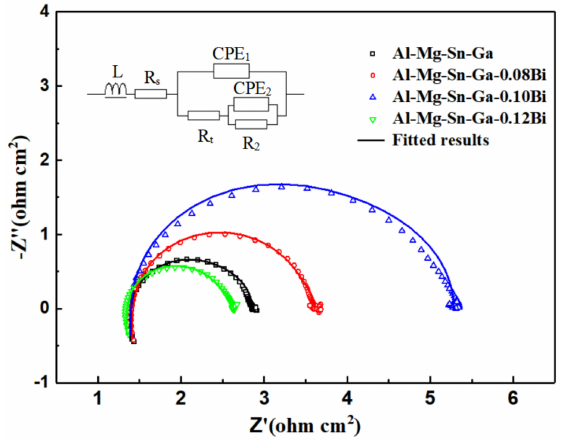
Figure 8. EIS patterns of the Al-Mg-Sn-Ga-xBi alloys and the equivalent circuit. Table 4. EIS fitted values of the Al-Mg-Sn-Ga-xBi alloys. Alloy 1 Alloy 2 Alloy 3 Alloy